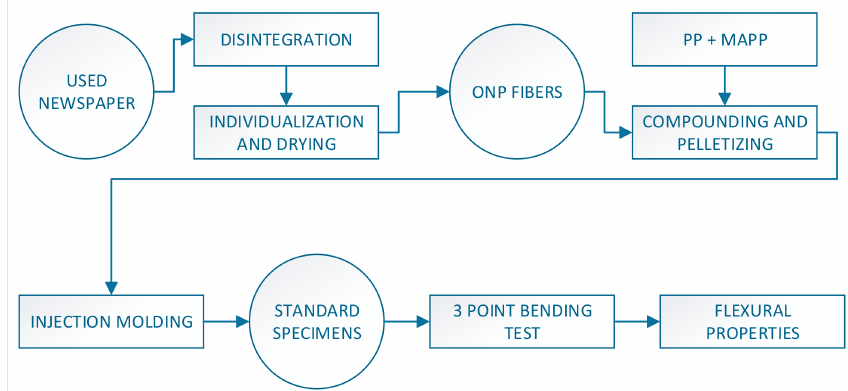
Figure 1. Flowchart of the research, from the raw materials to the experimental